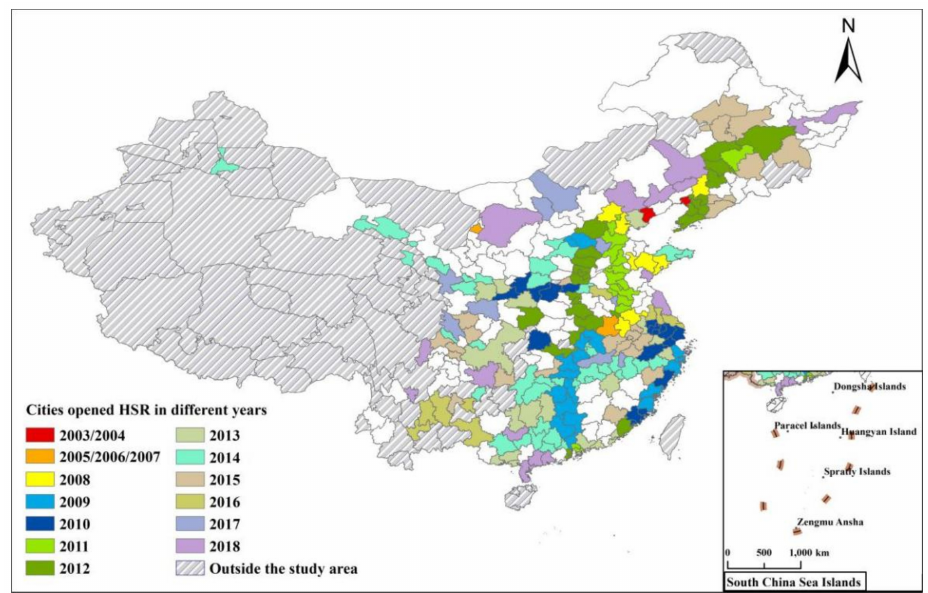
Figure 1. Cities that opened HSR in China from 2003 to 2018.